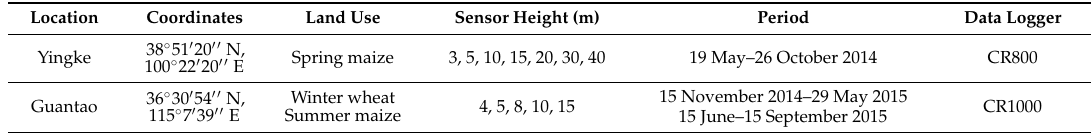
Table 1. Details about the observation sites.